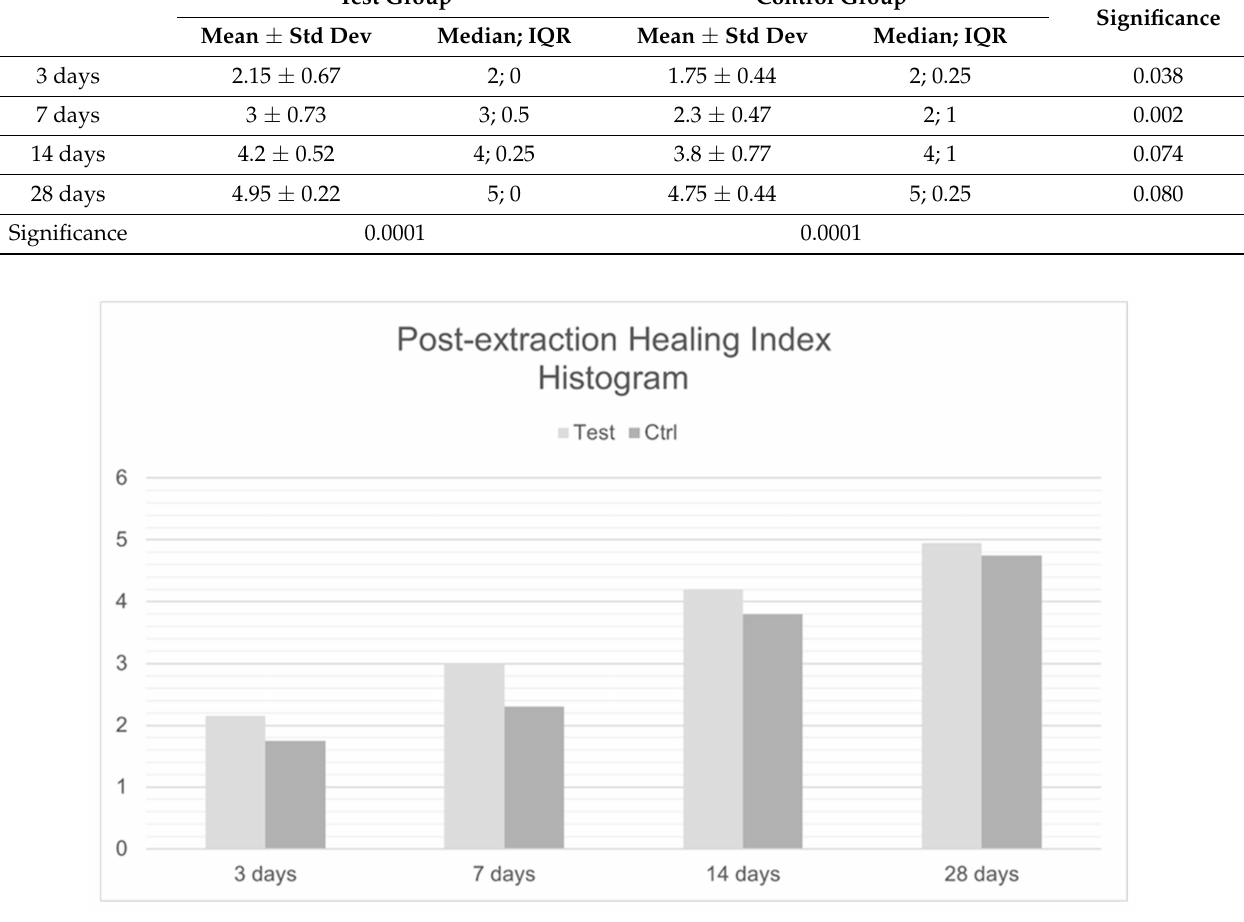
Figure 9. Post-extraction Healing Index Histogram.